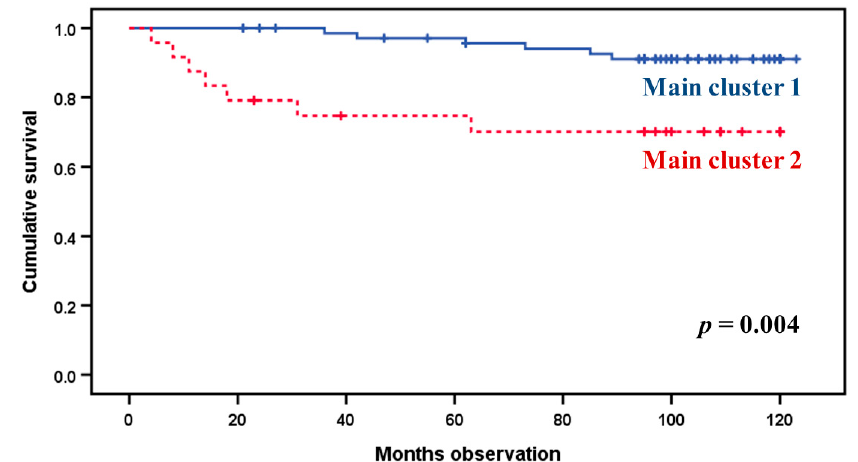
Figure 5. Comparison of cancer-related death for patients in the two main clusters identified in the hierarchical clustering analysis based on the systemic levels of 10 cytokine mediators (see Figure 4; upper main cluster 1, lower main cluster 2). All 97 patients were included in this comparison. A Kaplan–Meier analysis was performed, and the p -value for this comparison is indicated in the figure.